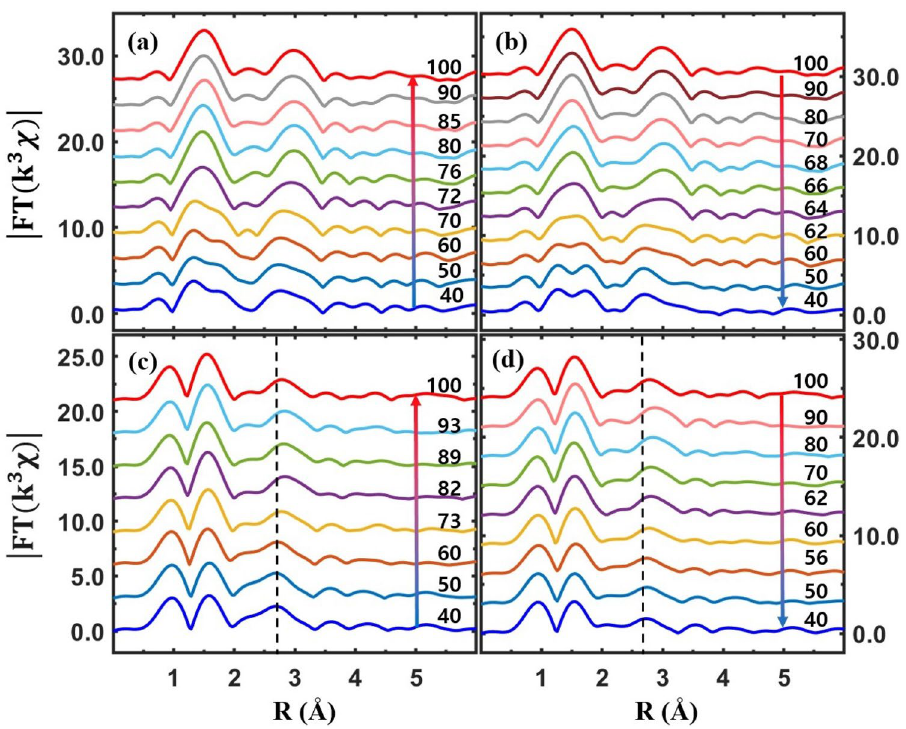
Figure 8. Magnitude of Fourier transformed EXAFS (|FT(k 3 χ )|) as a function of the distance from a V atom at different temperatures. ( a , b ) EXAFS of Cr-VO 2 with a Cr ion energy of 50 keV and a flux of 10 13 ions/cm 2 for heating and cooling, respectively. ( c , d ) EXAFS of Cr-VO 2 with a Cr ion energy of 50 keV and a flux of 5 × 10 13 ions/cm 2 for heating and cooling, respectively. The data are vertically shifted for clarity. The vertical dashed lines indicate the position of eight V atoms located at the vertexes of a rutile VO 2